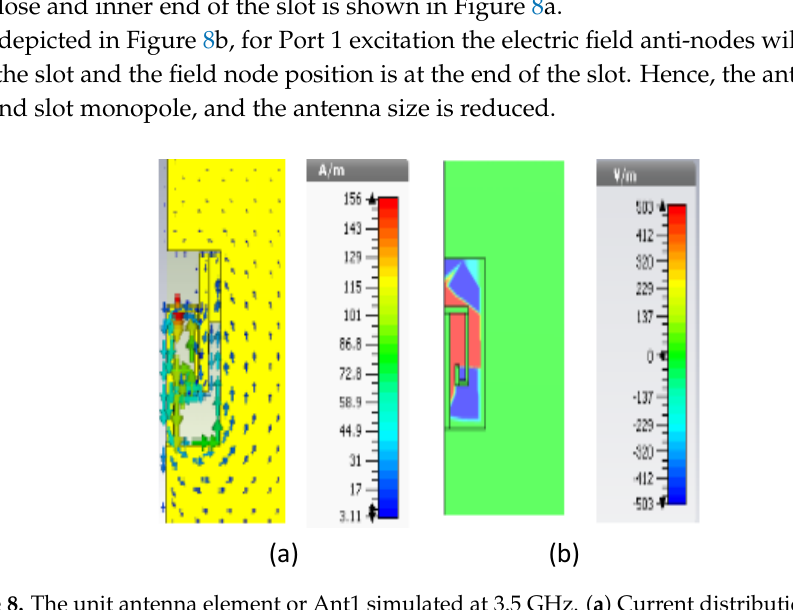
Figure 8. The unit antenna element or Ant1 simulated at 3.5 GHz. ( a ) Current distribution. ( b ) Electric field